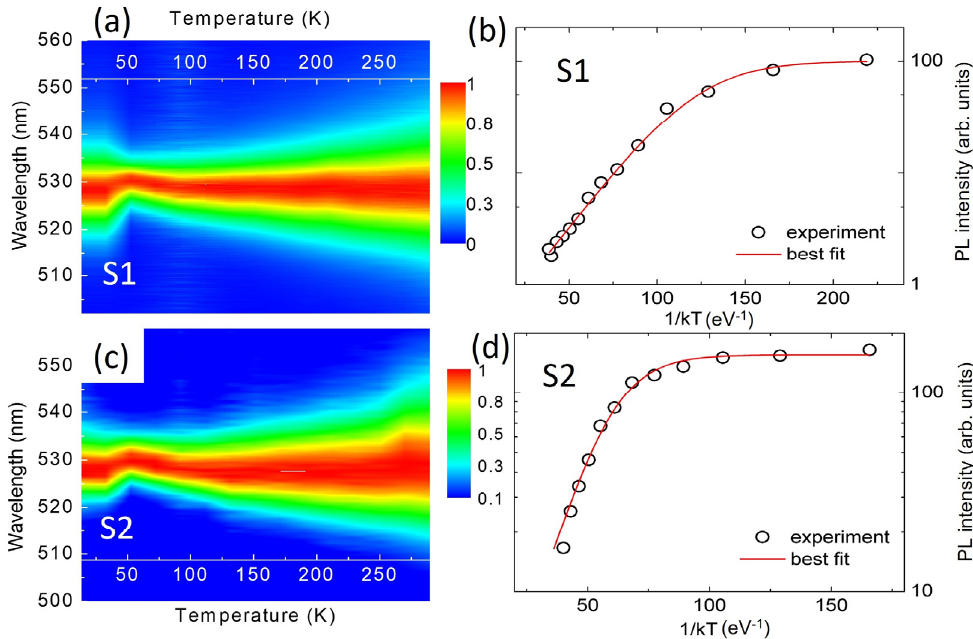
Figure 4. ( a , c ): 2D maps of the normalized emission spectra obtained at an excitation density one-half below the threshold. The detrapping process up to 50 K and the intrinsic nature of the emission at higher temperatures is evident. Temperature-induced broadening is also evident. ( b , d ) Arrhenius plot of the PL intensities of sample S1 ( b ) and S2 ( d ) as a function of the temperature (symbols), analyzed for T > 50 K. Continuous lines are the best fit curves to Equation (2).